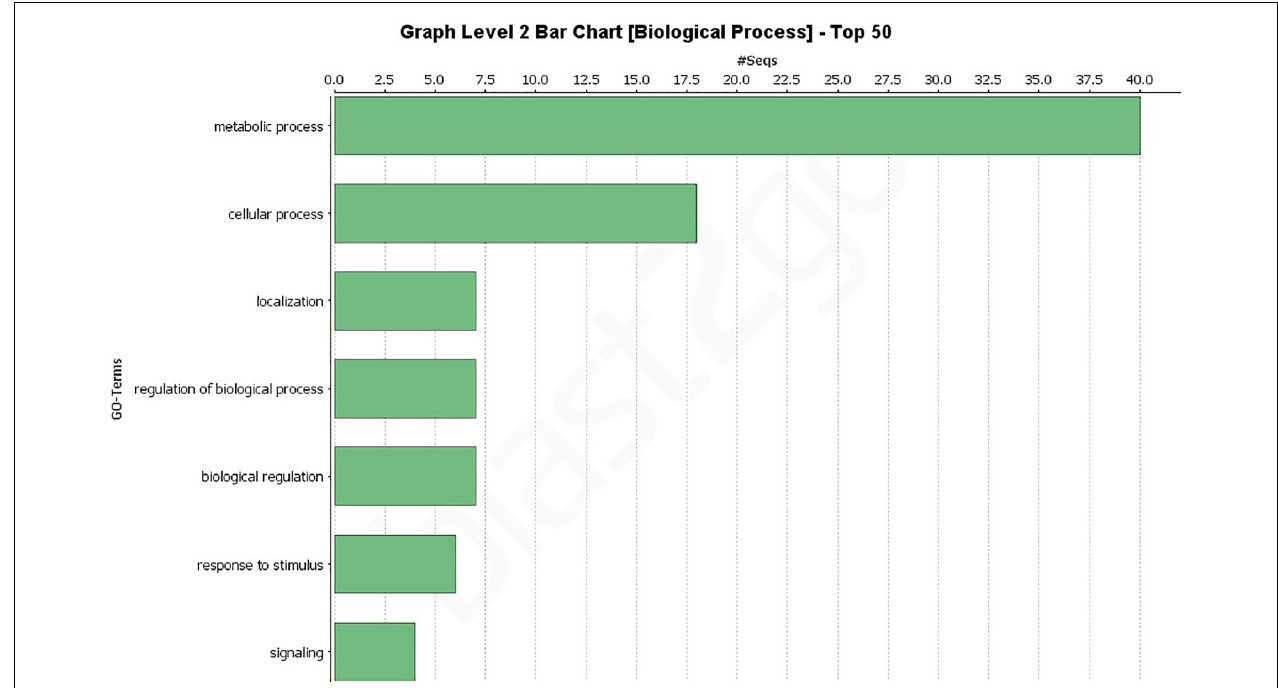
FIGURE 2 | Gene Ontology (GO) level 2 bar chart of the biological processes of all 193 effectors found across 18 genomes and the JR2 reference genome. See Supplementary Figure 1 for full network analysis of all 193 effectors.